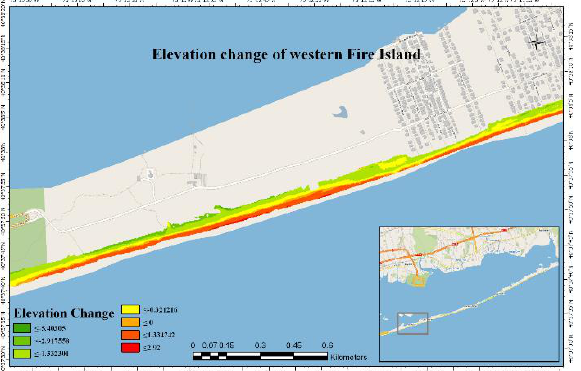
Figure 6. Elevation changes of western Fire